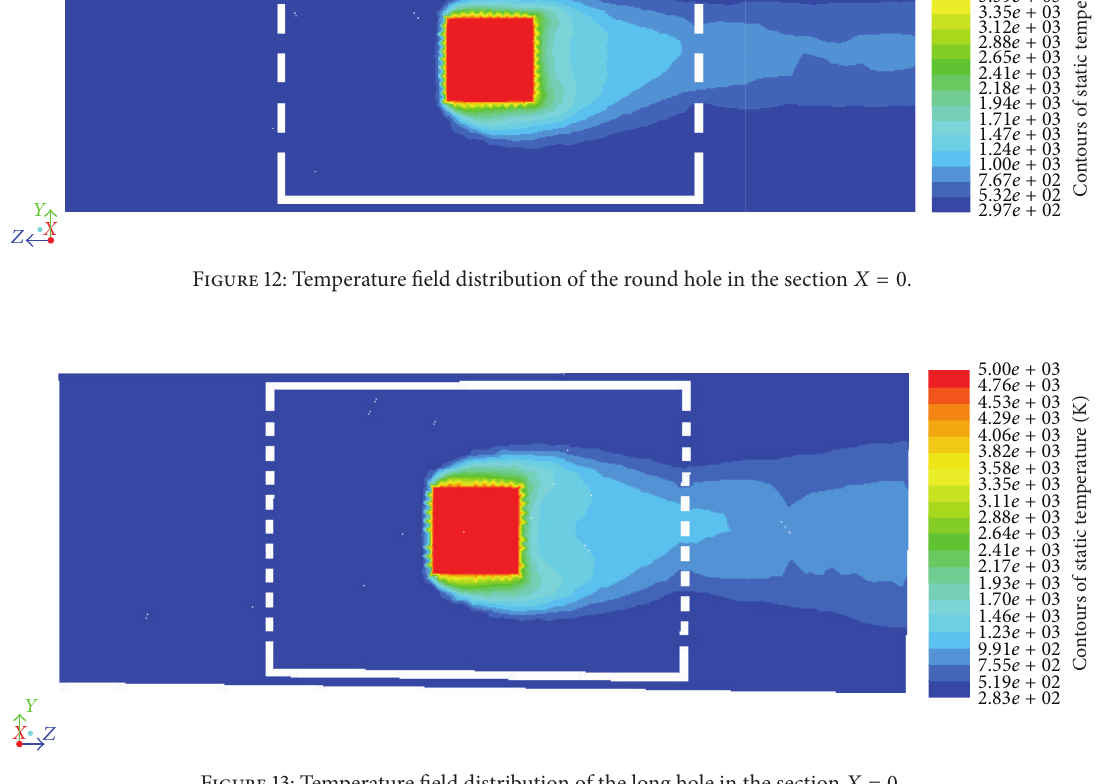
Figure 13: Temperature field distribution of the long hole in the section 𝑋 = 0 .